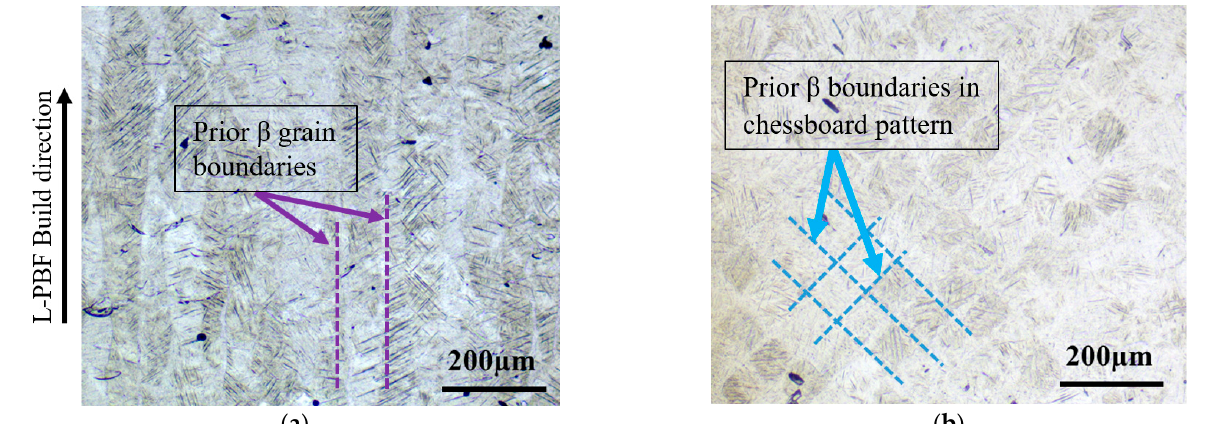
( b ) Figure 7. EDS analysis of ( a ) as-built L-PBF fabricated part, ( b ) PM sample (750 MPa/1250 °C). This is expected as the rapid cooling encountered during L-PBF does not allow dif- fusion to take place. Optical micrographs of the L-PBF parts illustrated in Figure 8a reveal the columnar grain architecture of the martensitic microstructure, which is parallel with